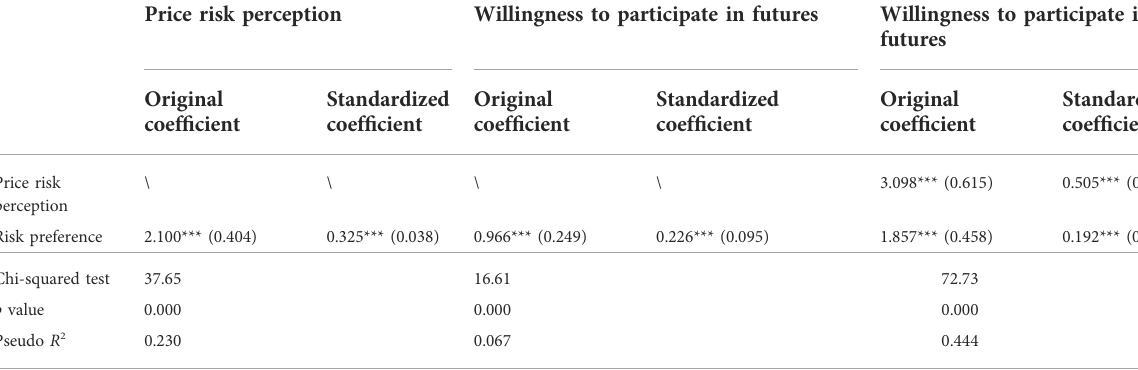
TABLE 5 The mediating effect of the willingness of leading enterprises to participate in